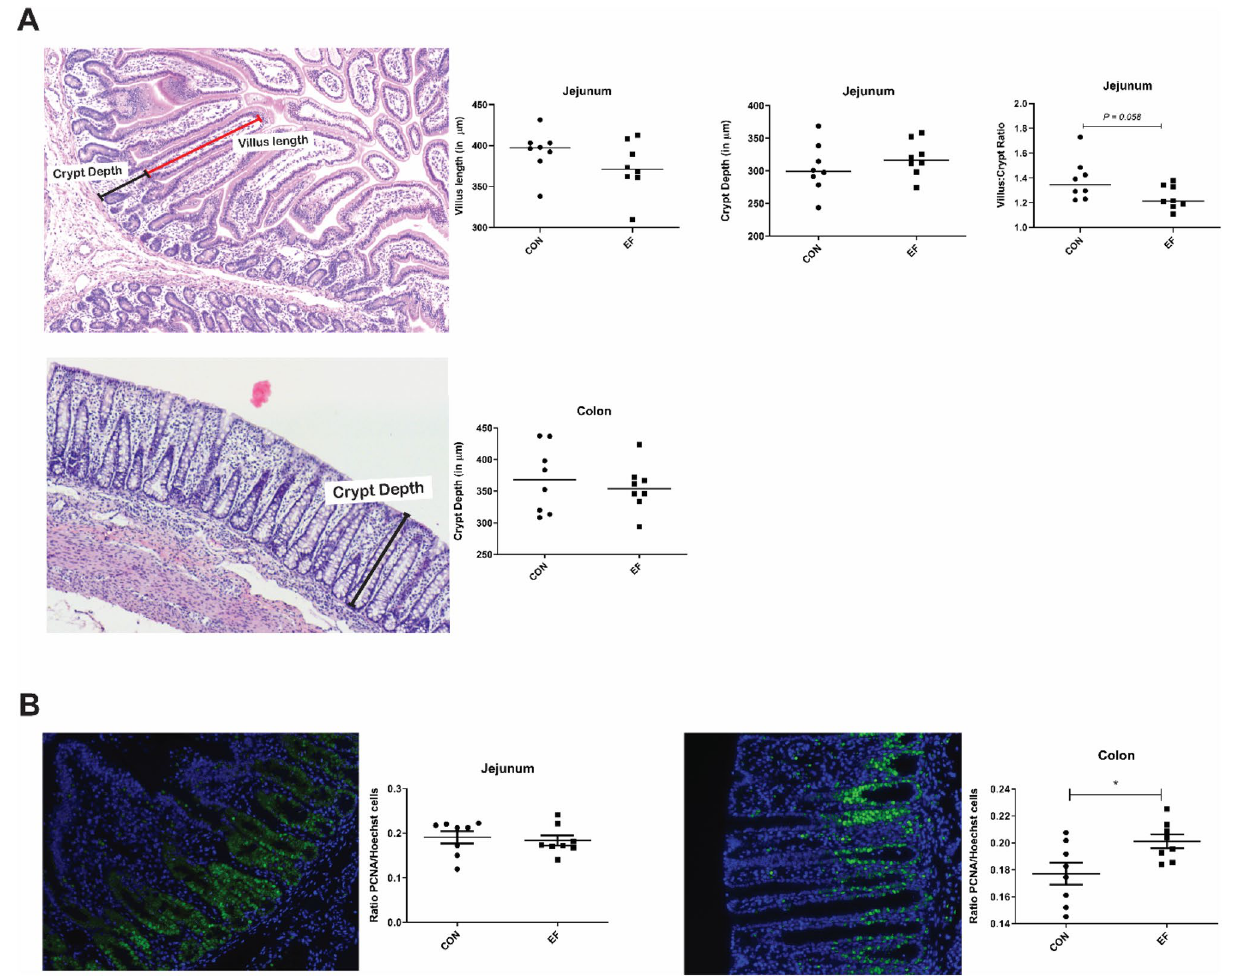
Figure 5. Effects of early feeding on ( A ) intestinal morphometry and ( B ) PCNA + proliferating cells in jejunum and colon (representative image) at weaning (day29). Hoechst and PCNA positive cells are represented in blue- and green-coloured cells respectively. EF = early-fed group; CON = control group. Differences between groups were assessed by student t test or Mann–Whitney U test (*, P < 0.05). The bars in these images illustrate the measured parameters. Representative images of CON and EF groups can be found in Supplementary Fig.